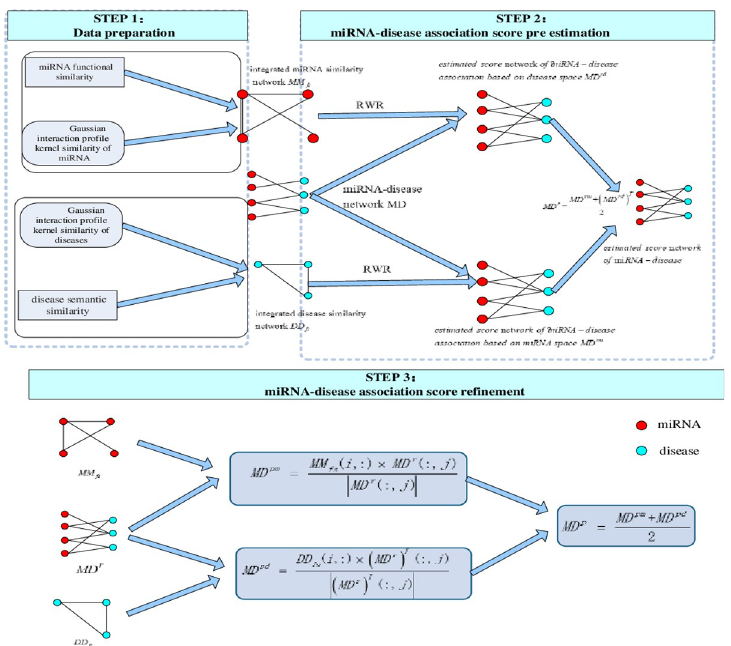
Fig 1. Flowchart of the whole modeling